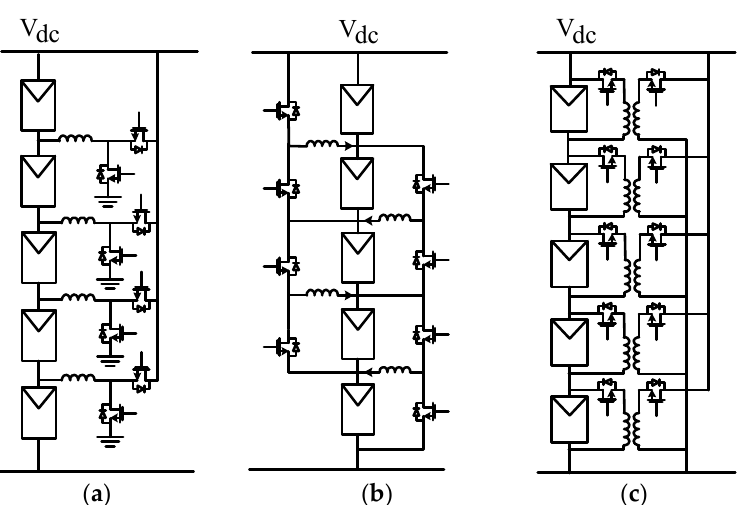
Figure 21. Differential power processing schemes: buck based ( a ); buck-boost based ( b ); flyback based ( c ) [45].